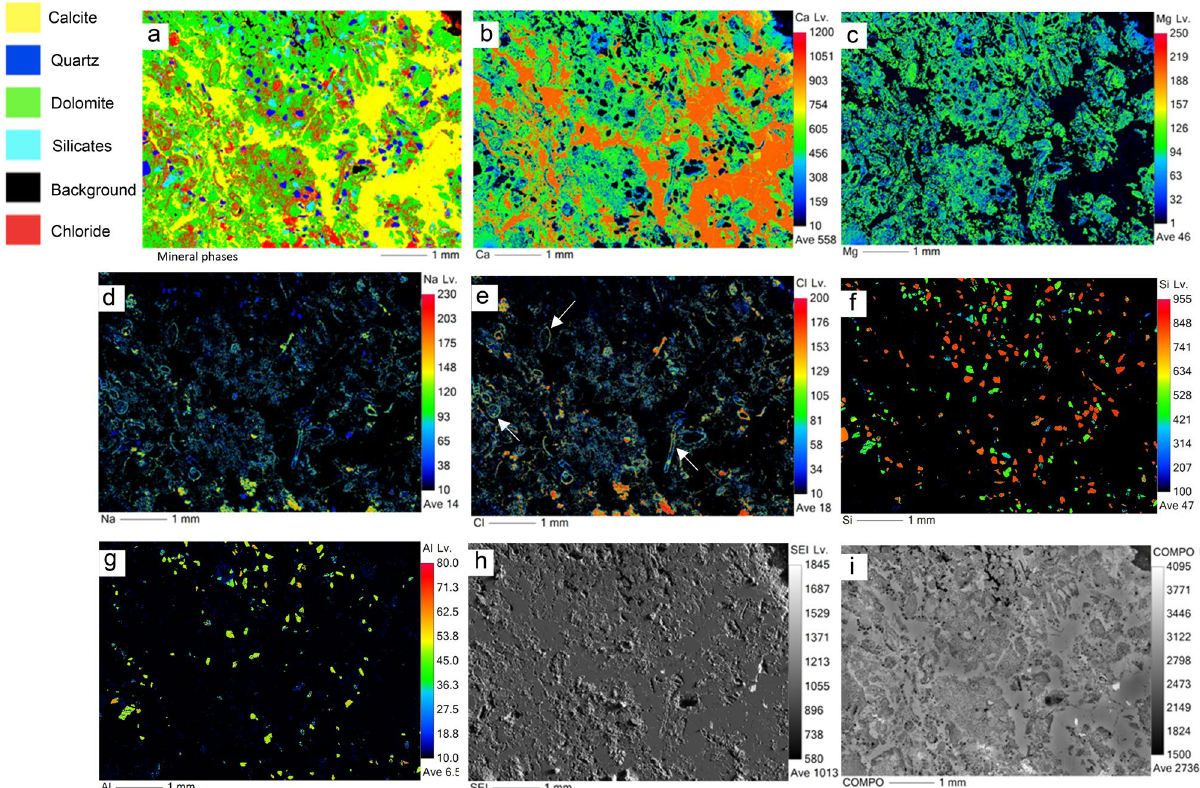
Figure 6. EPMA results of MV2 showing: ( a ) mineralogic maps, elemental maps of ( b ) Ca, ( c ) Mg, ( d ) Na, ( e ) Cl, ( f ) Si, and ( g ) Al, ( h ) secondary electron image, and ( i ) backscattered image. Arrows in panel ( e ) point microfossils, likely foraminifera. Some foraminifera in the coastal mud volcano were identified by Hyžný et al. (2018) such as Elphidiella sp.; Elphidium cf. macellum ; Praeorbulina glomerosa ; Quinqueloculina seminula ; Quinqueloculina badenensis ; and Spiroloculina